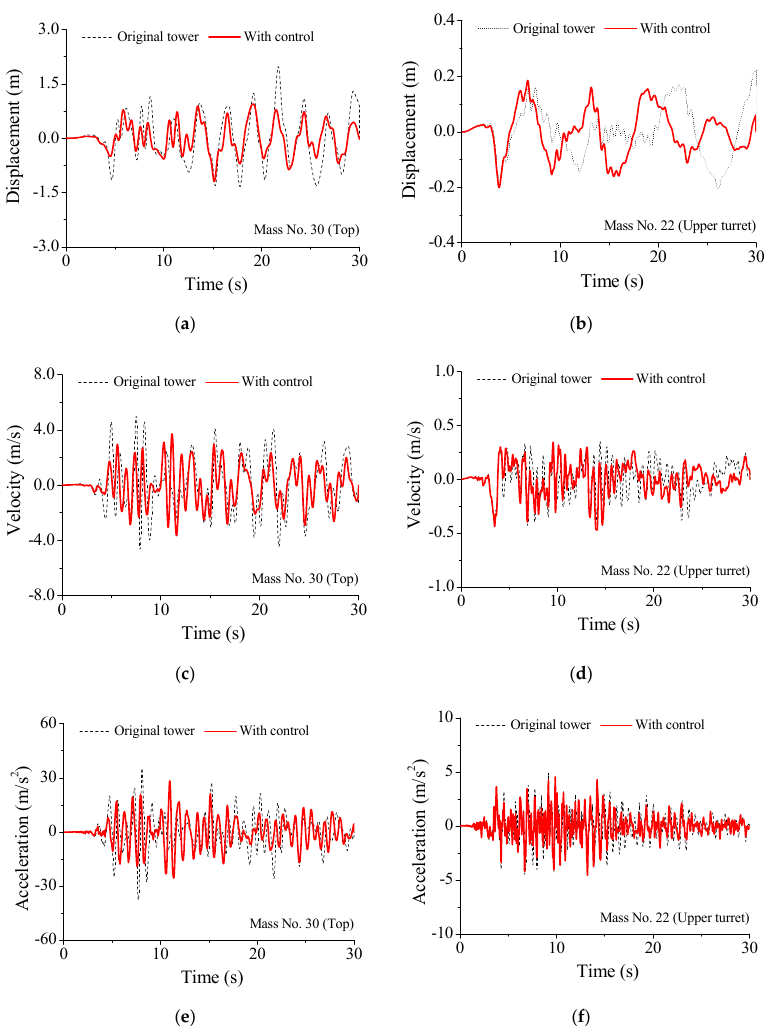
Figure 6. Time histories of dynamic responses of the television tower. ( a ) Displacement No.30; ( b ) Displacement No.22; ( c ) Velocity No.30; ( d ) Velocity No.22; ( e ) Acceleration No.30; ( f ) Acceleration No.22.